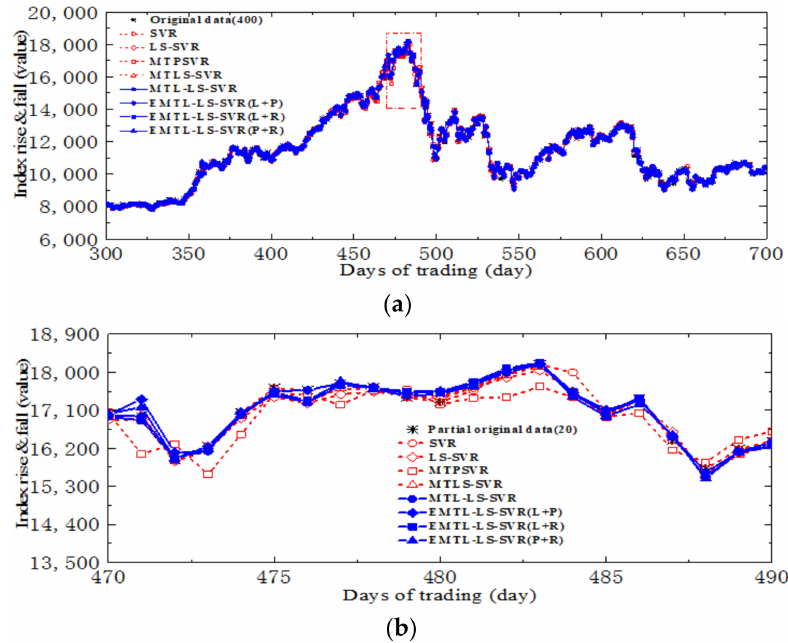
Figure 5. Predictions of different regression models on opening index for SZI ( a ) Original figure, ( b ) Enlarged figure.